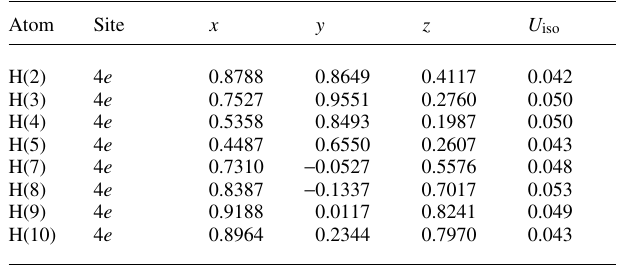
Table 2. Atomic coordinates and displacement parameters (in Å 2 )